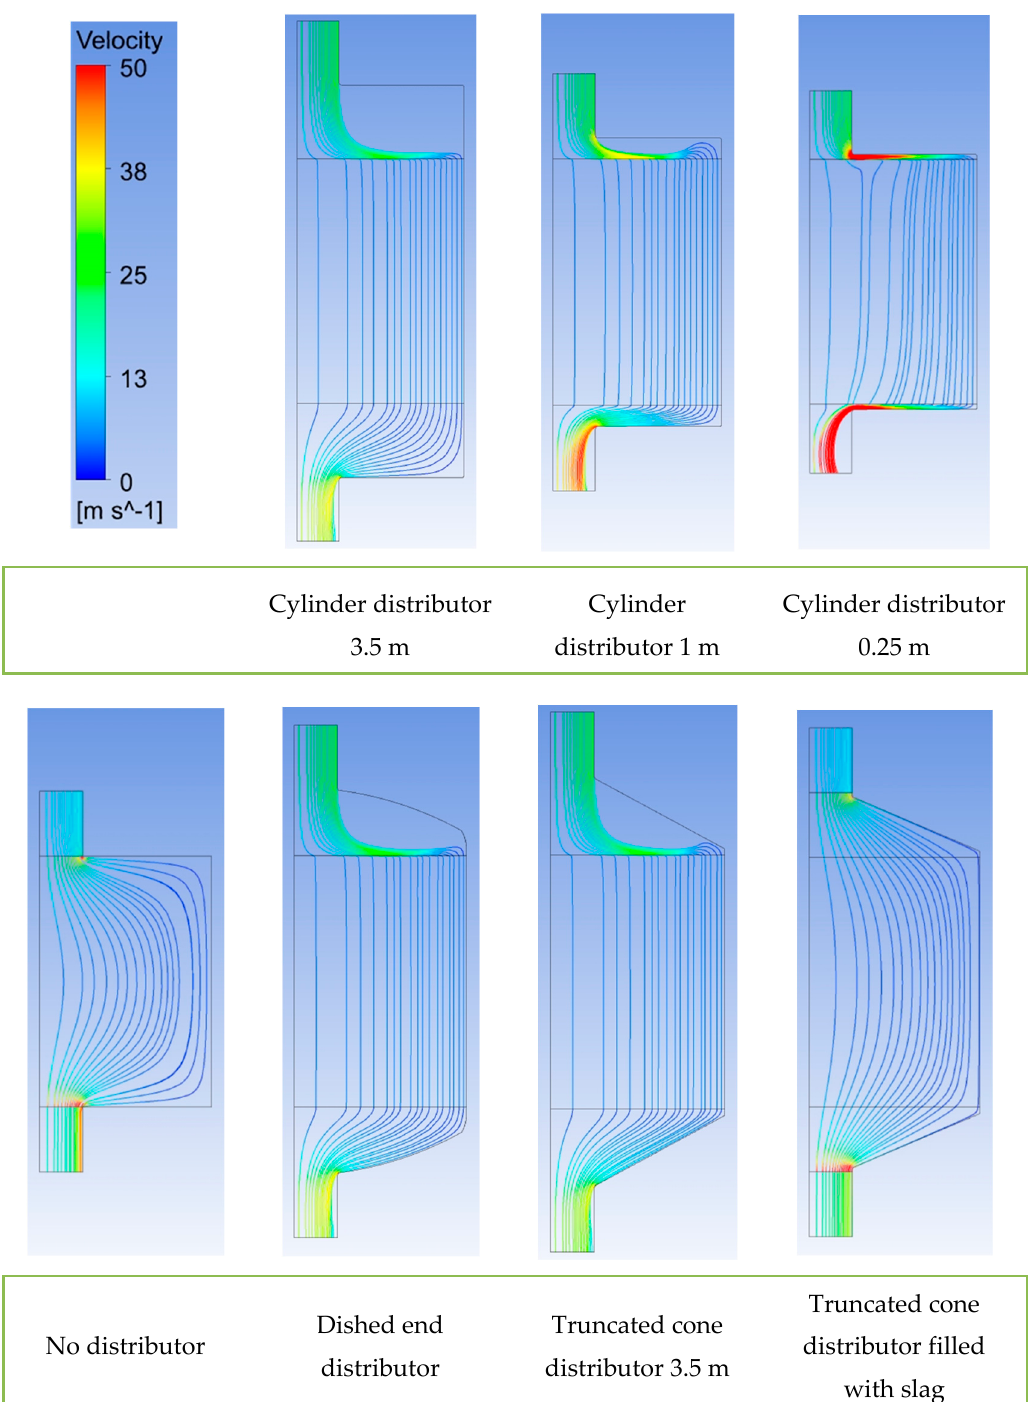
Figure 11. Streamline plots for seven different design options for the distributor. Case “Charging, full load”.